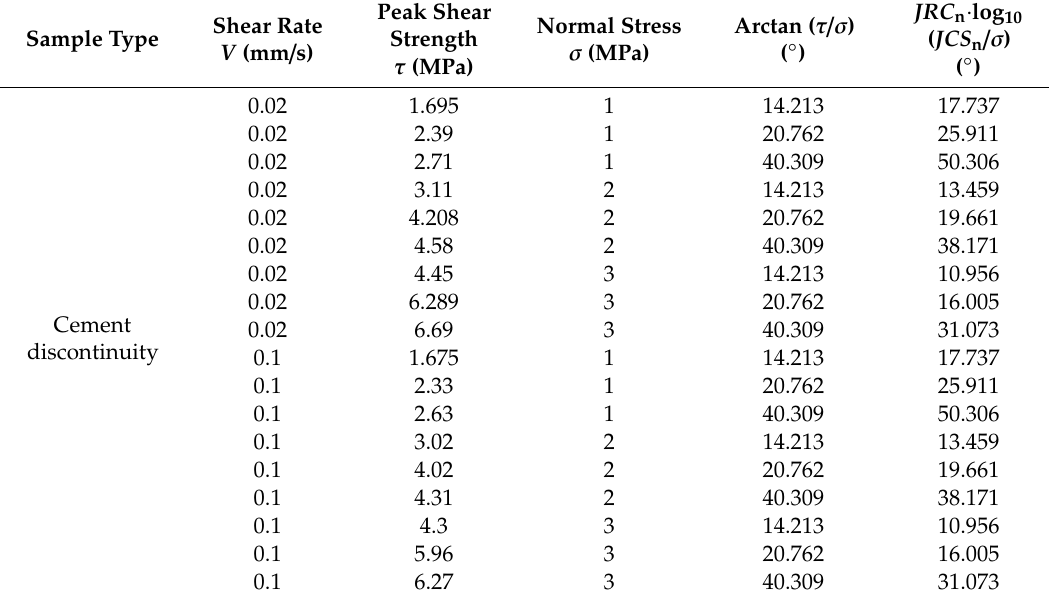
Table A4. Test data of di ff erent cement discontinuity samples with the shear rate varying from 0.02 mm / s to 1 mm / s (after